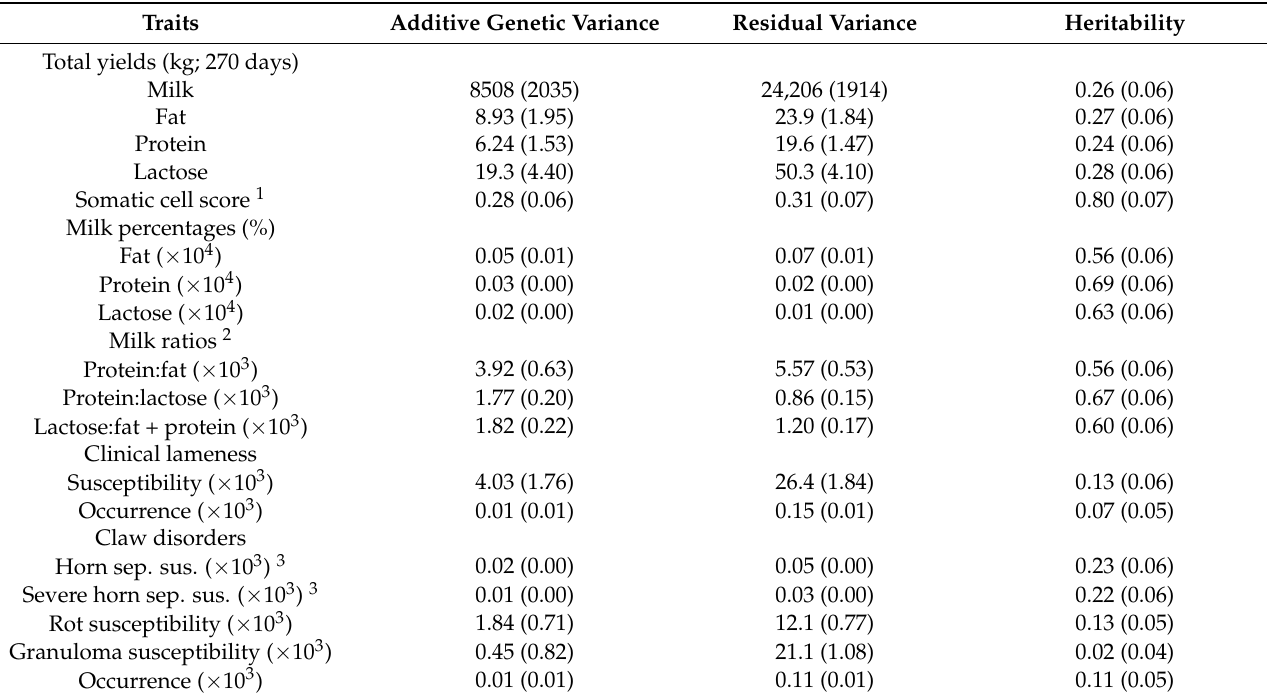
Table 2. Estimates of additive genetic and residual variances, heritability, and the corresponding standard errors in parenthesis for milk production, lameness, and claw disorder traits in dairy goats from three farms within New Zealand collected between July 2019 and June 2020 production